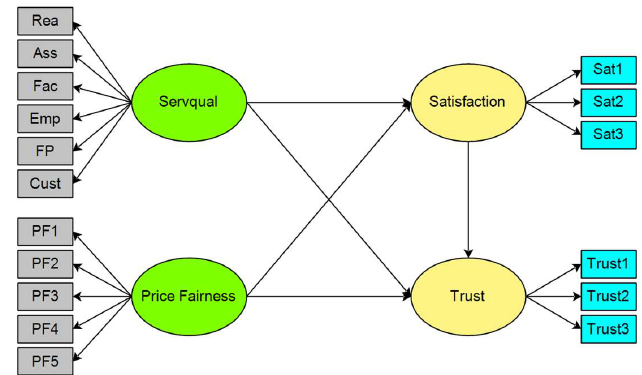
Fig. 1. Conceptual